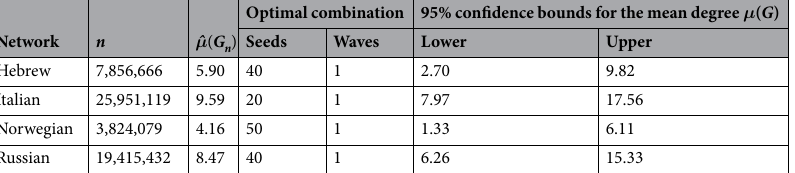
Table 3. The 95% FPB confidence intervals for the mean degrees of Wikipedia networks, constructed based on the links (edges) between talk and user pages (nodes) in different languages. The analysis considered 12 seed-wave combinations: seeds 20, 30, 40, and 50; waves from 1 to 3, and 500 bootstrap resamples per each combination. Cross-validation is based on a random selection of 10 seeds 10